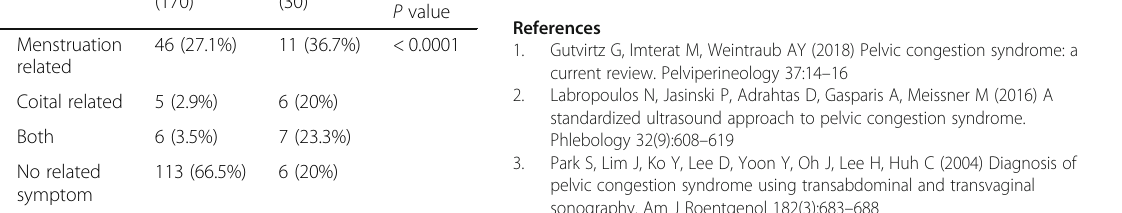
Table 3 Comparison between the 2 groups as regards CPP- related symptoms